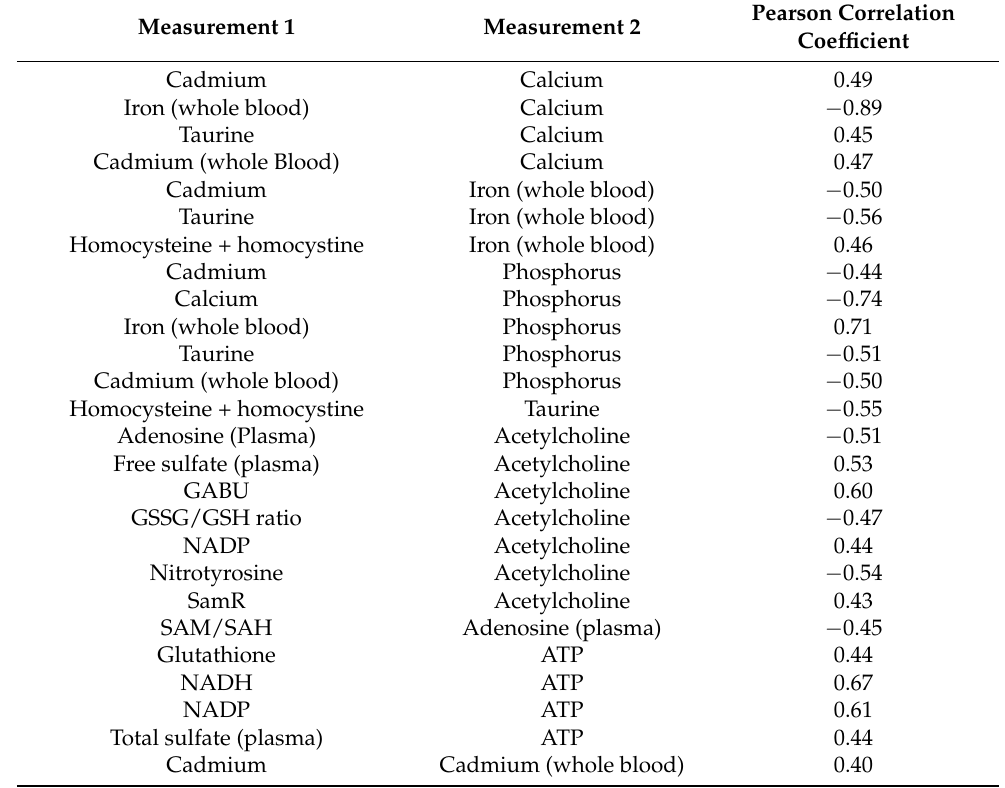
Figure A2. Boxplots of the FDA scores for both the 5-marker and 6-marker optimized model based upon cross-validated AUROC value. Each box represents scores that fall between the 25th and 75th percentile for that respective set of scores. Table A1. Correlations of top metabolites, xenobiotics, and elements for the ASD group with a Pearson correlation coefficient greater in magnitude than